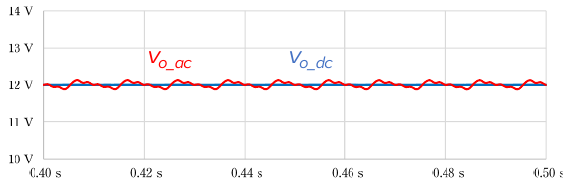
Figure 4. Dc-link voltage of the load when supplied by ac voltage ( v dc_ac ) and when supplied by dc voltage ( v dc_dc ).